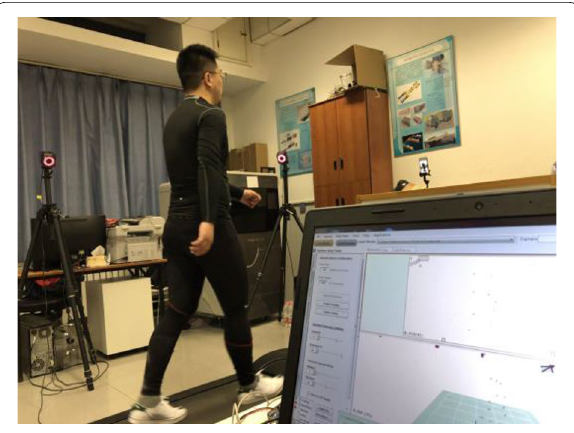
Figure 3 Testing platform for human gait